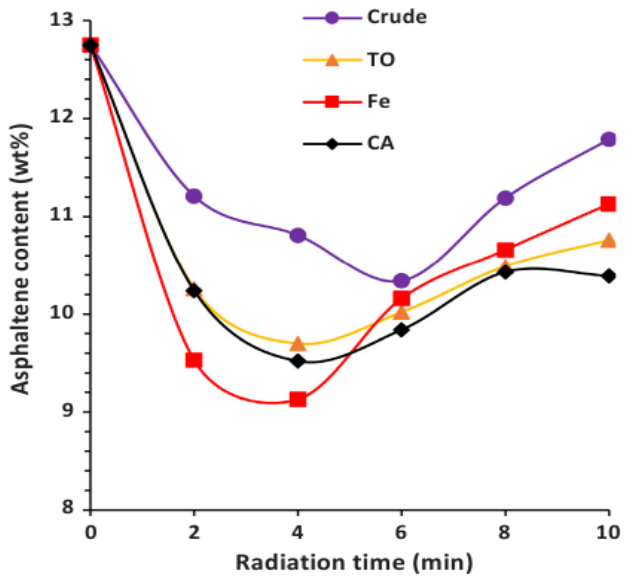
Figure 7. Content of asphaltenes variation in relation to radiation time. Reproduced with permission from [99], Copyright Elsevier, 2018.